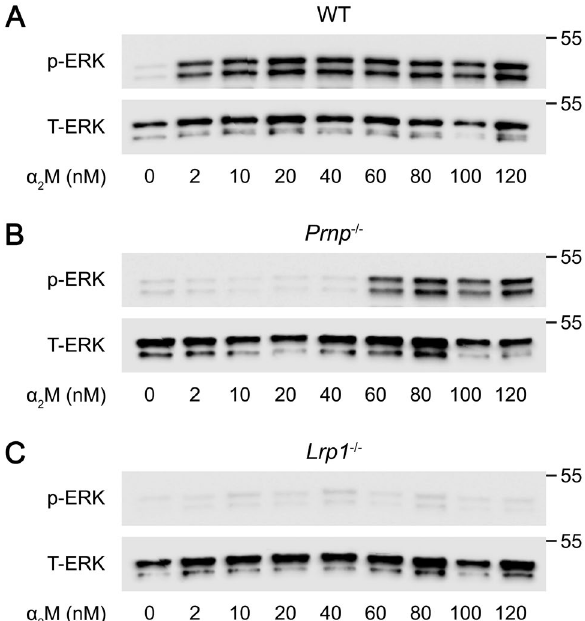
Figure 5. Membrane-anchored PrP C facilitates and LRP1 is essential for activation of ERK1/2 by α 2